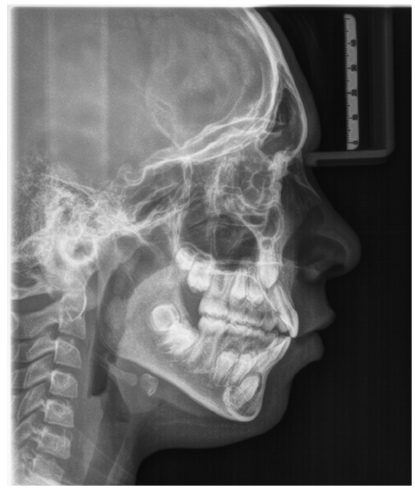
Figure 5. Rx OPT before orthodontic treatment.